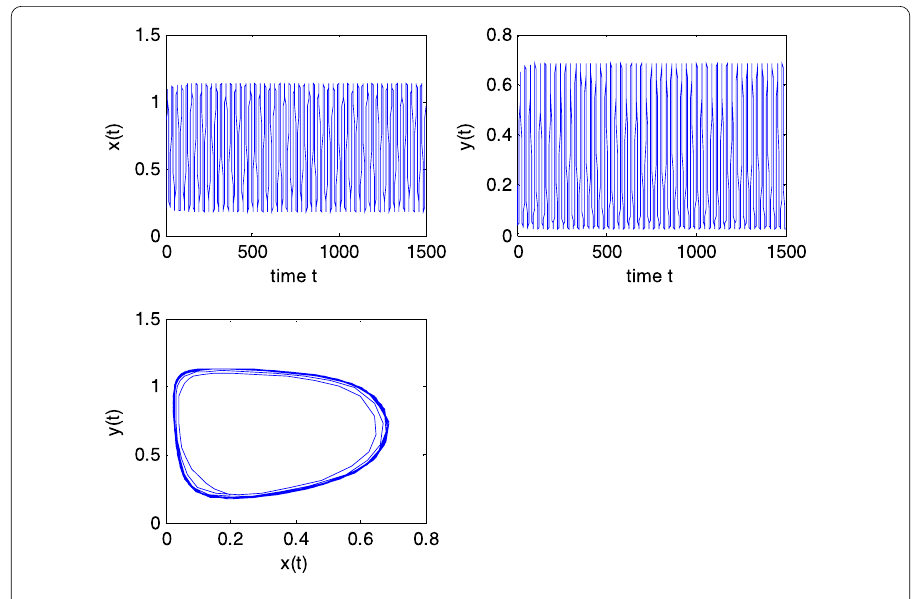
Figure 7 Behavior and phase portrait of a controlled system (1.3) with α = 1, β = 0.1, τ 1 = 0, τ 2 = 3.7 > τ 0 . The positive equilibrium ( 2 2